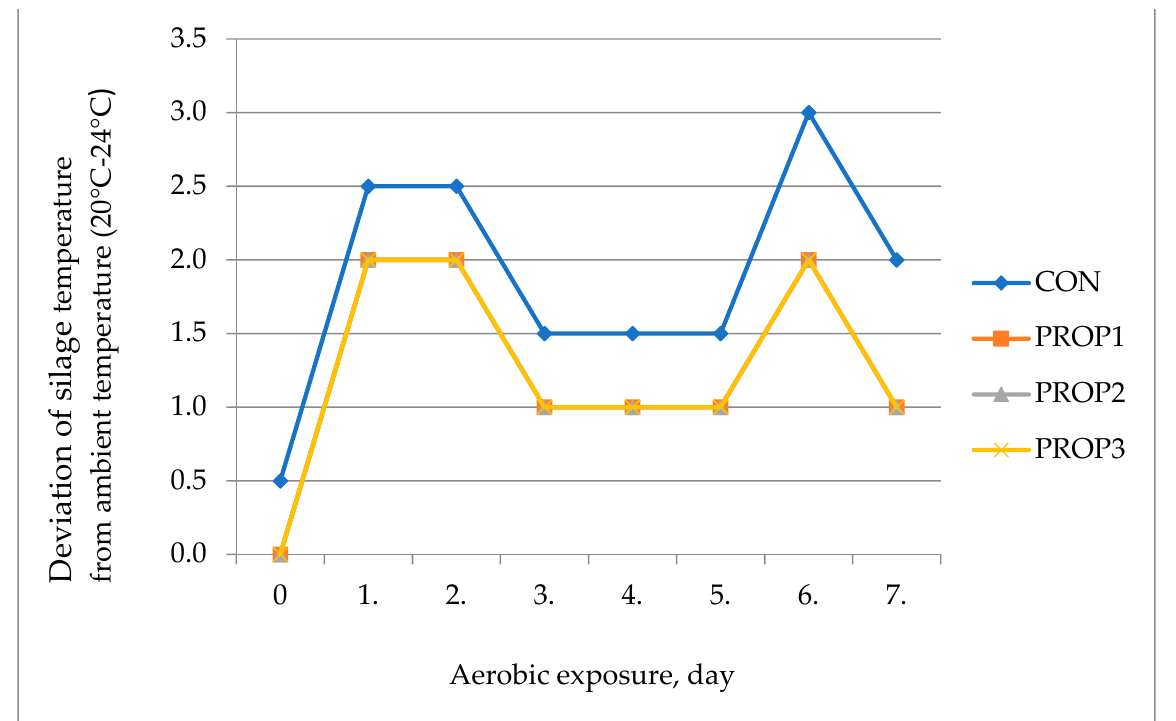
Figure 1. Deviation of silage temperature from ambient temperature (20 °C − 24 °C) during 7 days of aerobic exposure. CON, Control; PROP1, 1000 mg/kg propolis; PROP2, 2000 mg/kg propolis; PROP3, 3000 mg/kg propolis. Table 9. In vitro digestibility and ME contents of alfalfa silages (in DM). Item CON PROP1 PROP2 PROP3 SEM p